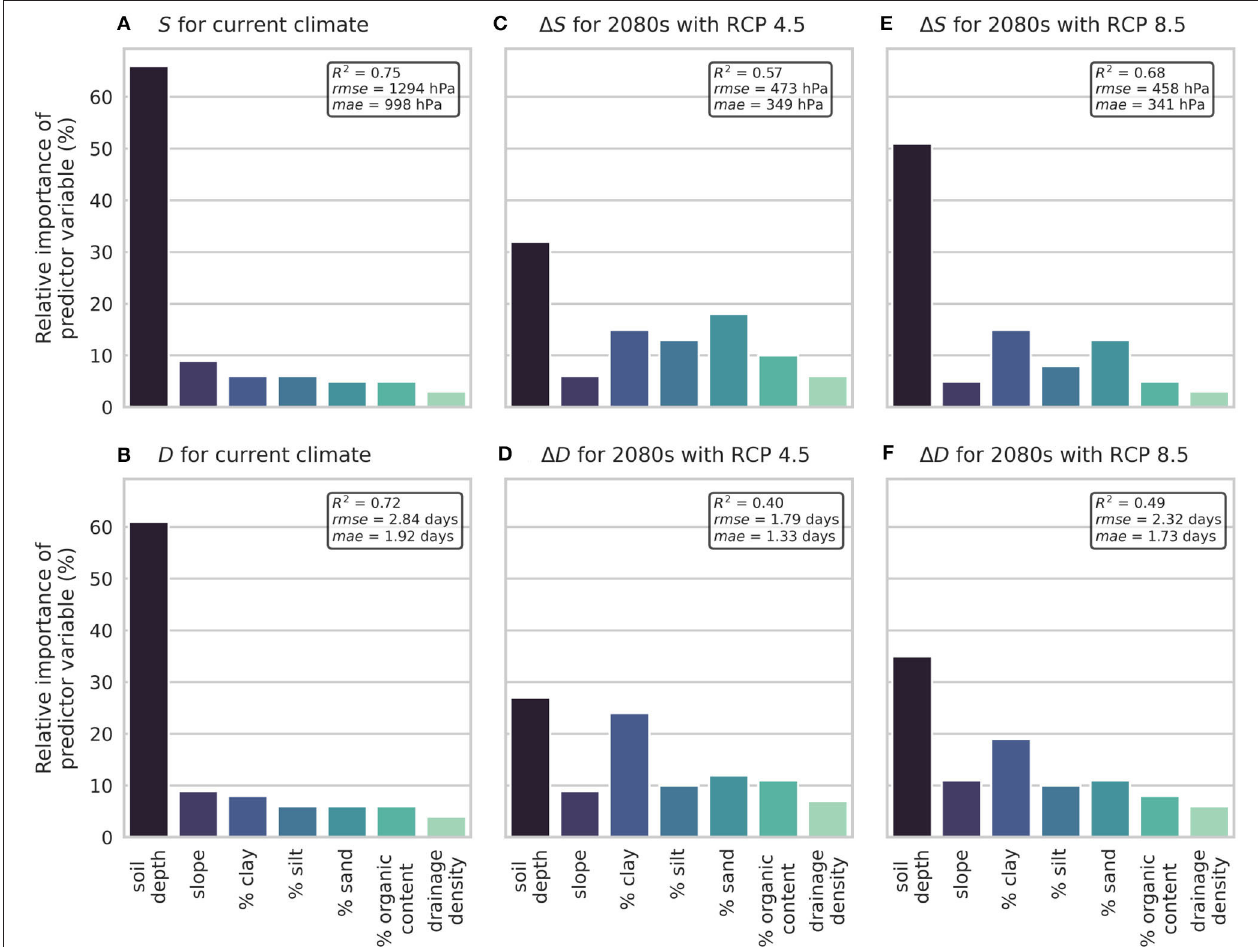
FIGURE 3 | Relative importance of predictor variables for (A,B) the severity S and duration D of soil water stress levels for the growing season (MJJASO) under current (1981–2010) climate conditions as well as for the projected changes in (C,D) the severity ( 1 S) and (E,F) the duration ( 1 D) of soil water stress levels under future climate conditions for the 2080s (2071–2100). Also shown is the root mean square error (RMSE) and the mean average error (MAE) of the random forest regressions.